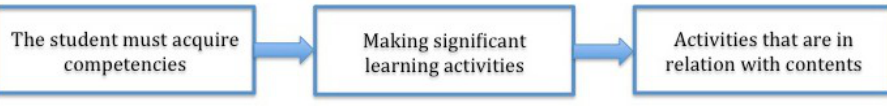
Figure 2. Methodology for the design of learning actvites oriented to